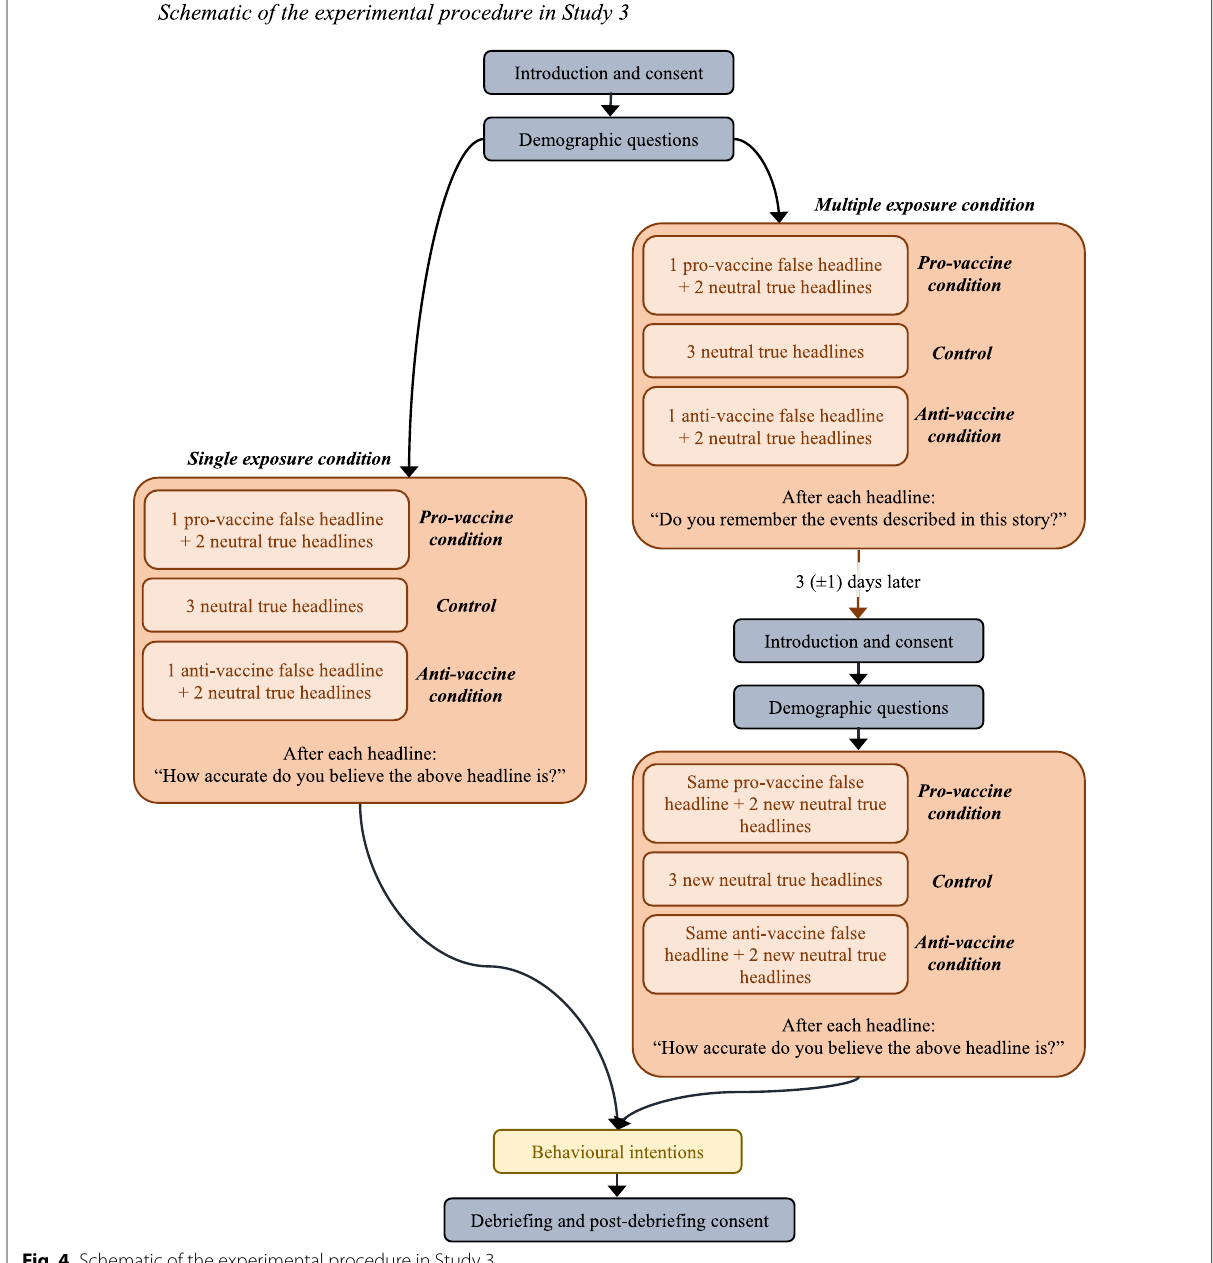
Fig. 4 Schematic of the experimental procedure in Study